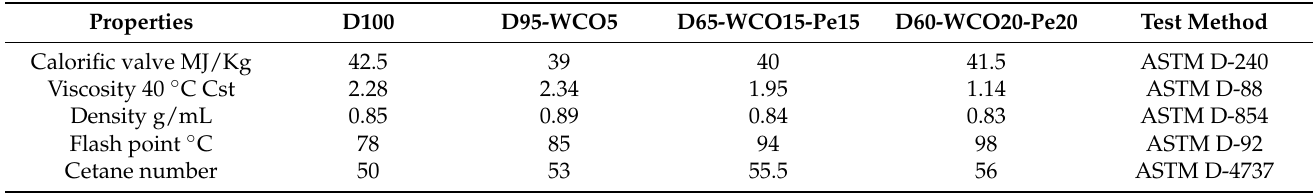
Table 2. Fuel Characterization.